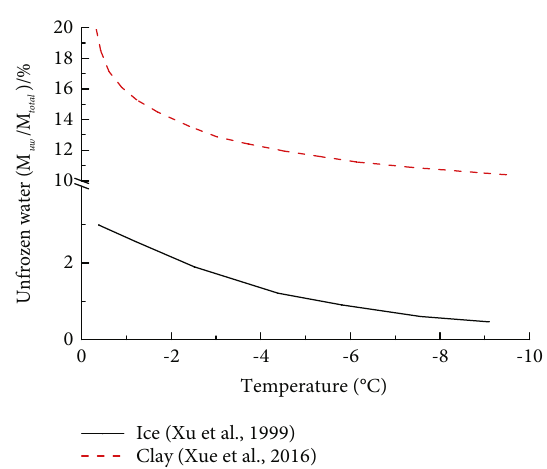
Figure 15: Variation curves of unfrozen water content in soil and ice with